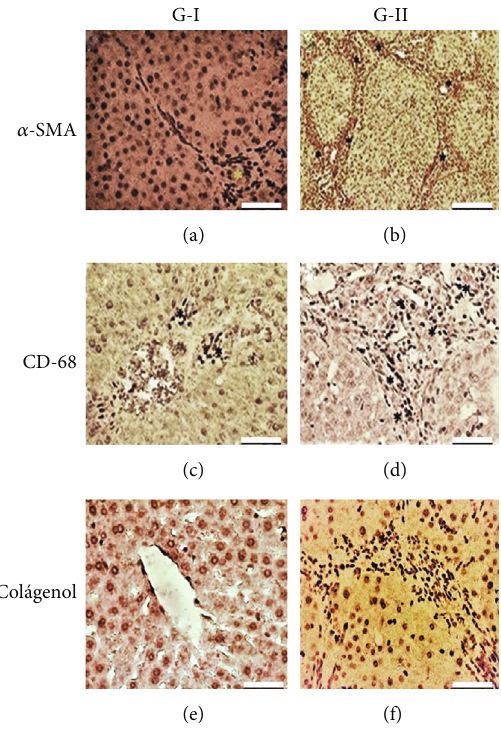
Figure 5: Molecular markers of chronic liver fi brosis: α -SMA, CD68, and Collagen I. (a, c, and d) G-I control liver and (b, d, and f) G-II liver with chronic liver fi brosis, IHC. Bar length = 50 μ m . ∗ : identi fi es the immunoreactivity of the cells to the speci fi c